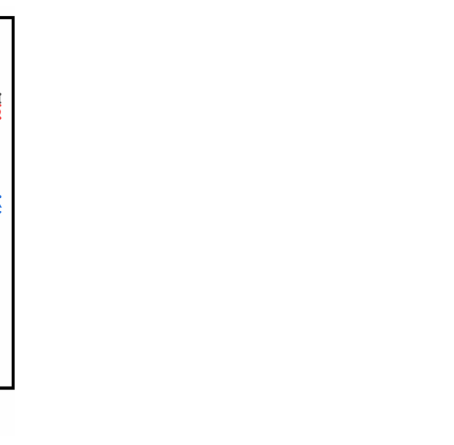
Figure 17. The effect of TiO 2 , MgO, and SiO 2 nanofluids on oil-wet calcite wettability at different salinities.